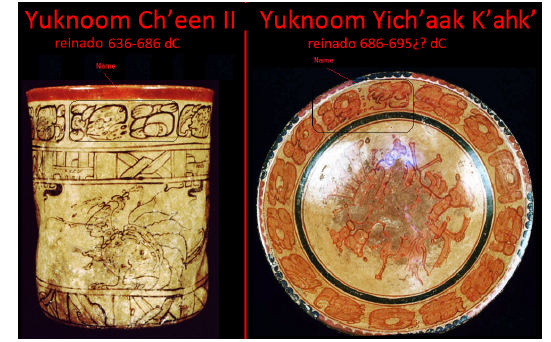
Fig. 3 . Hieroglyphic texts indicate that the vase (left) belonged to Yuknoom Ch’een II (the Great) and a plate (right) to Yuknoom Yich’aak K’ahk’, Ch’een II’s heir (names in squares). Reproduced with